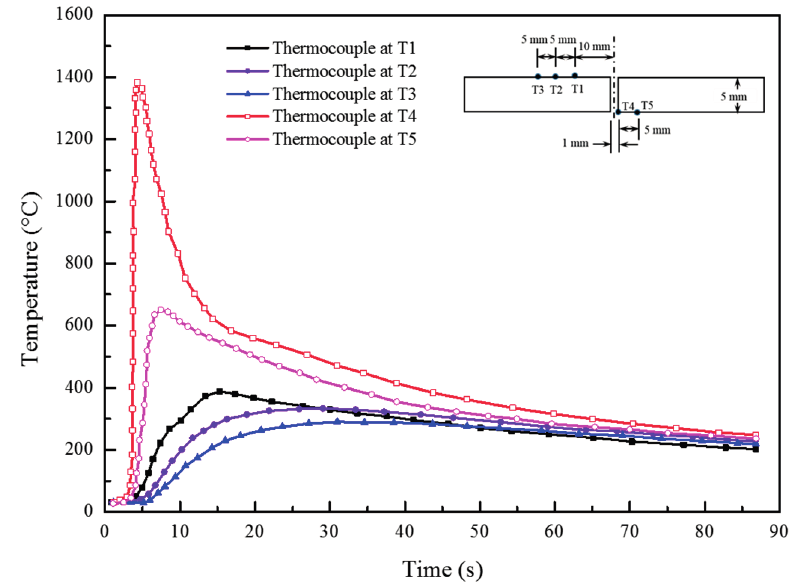
Figure 4. Peak temperatures at current 175 A.